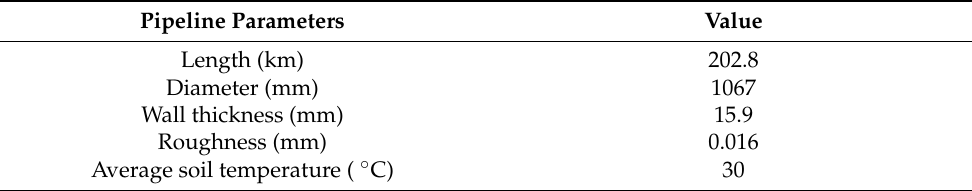
Table 1. Pipeline